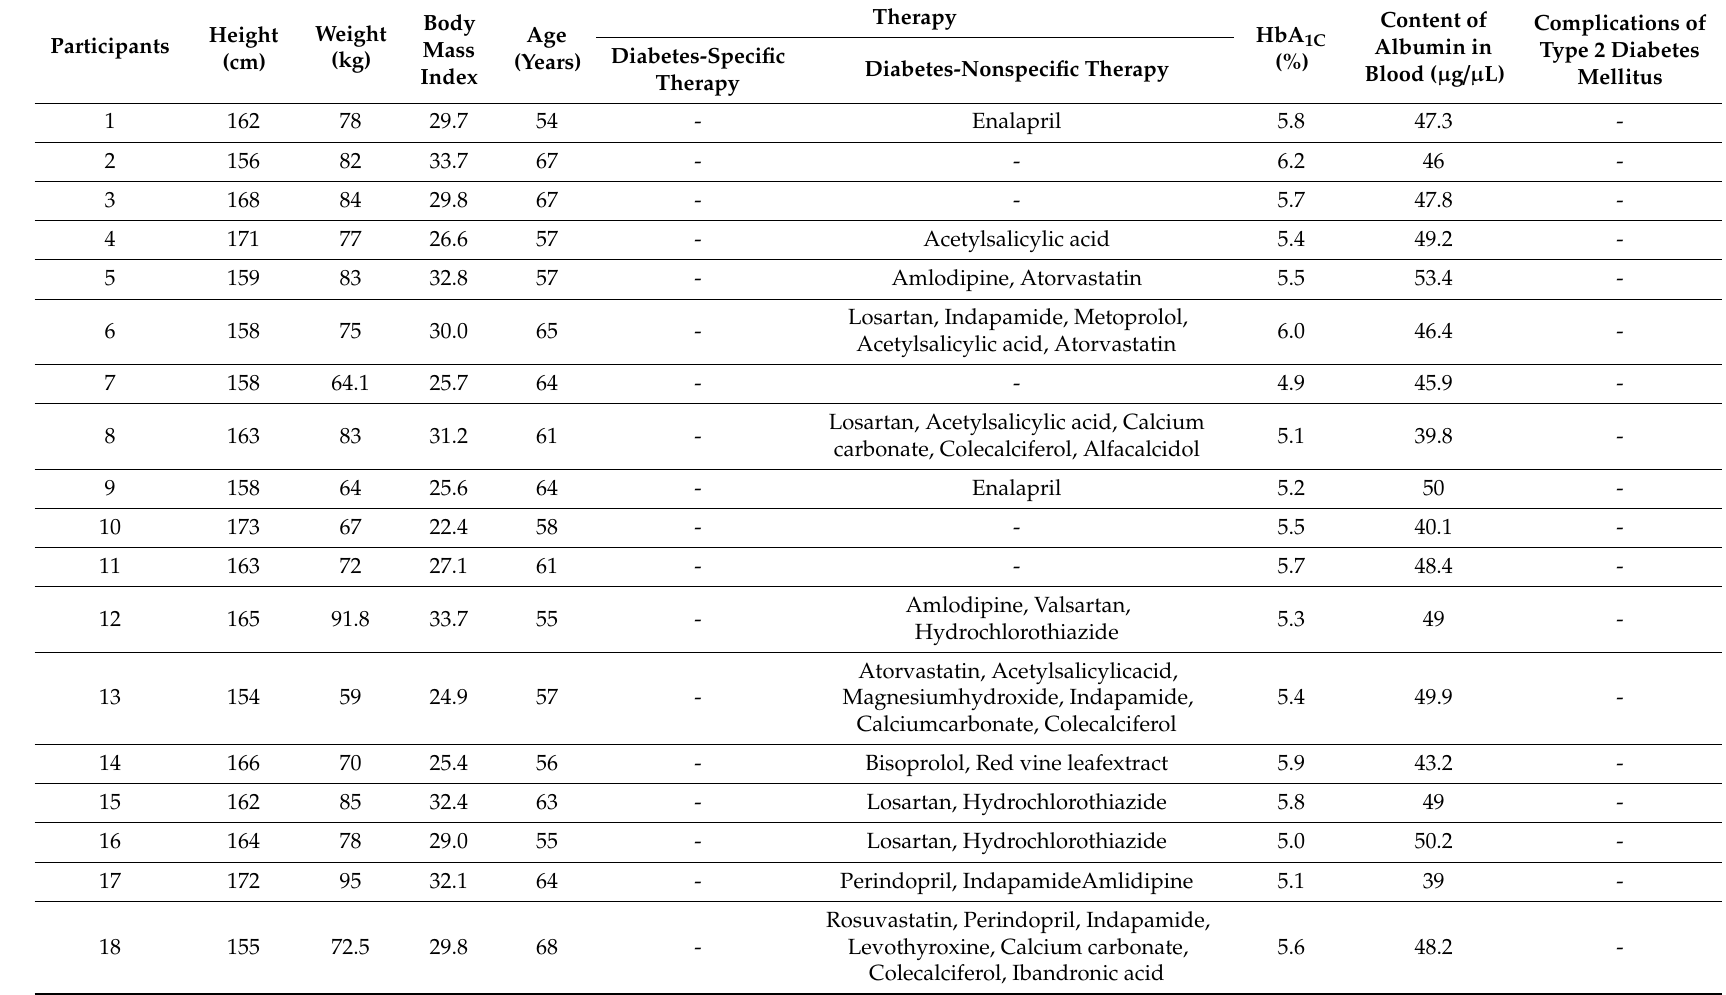
Table 5. Physical and biochemical parameters of individuals without diabetes, as well as corresponding therapy, not related to diabetes.